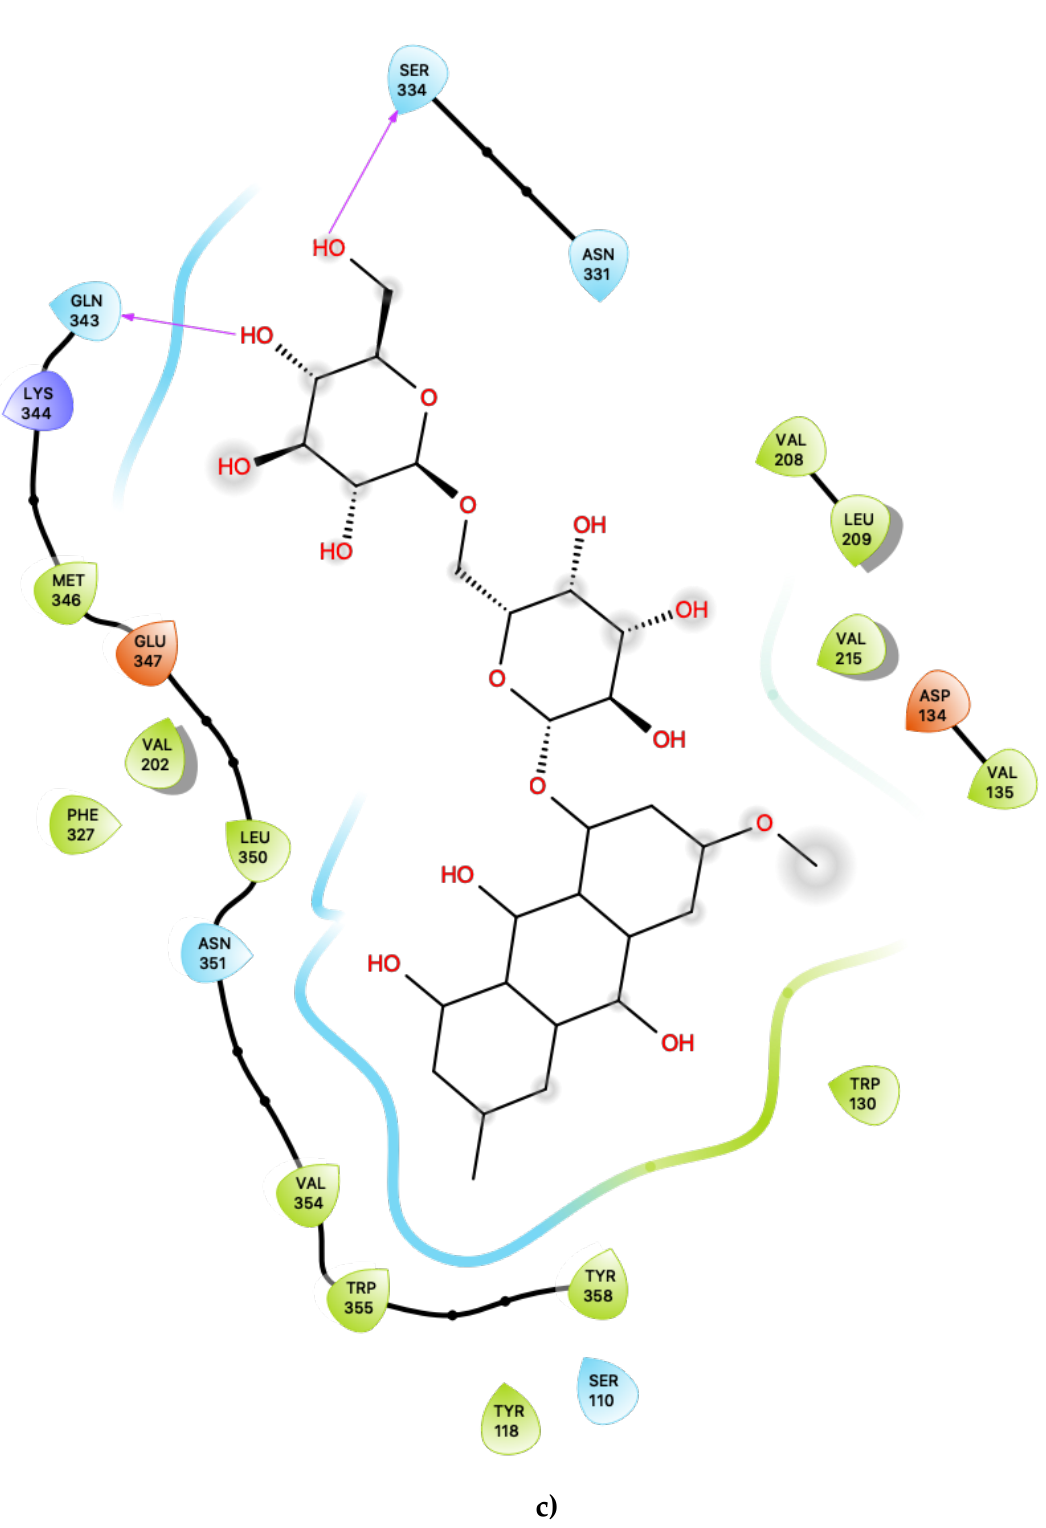
Figure 3. ( a ) Ligand-protein interaction of c06-S2, ( b ) c29-S2 and ( c ) c47-S2. Arrows indicate hydrogen bonds. Grey halos indicate solvent-exposed atoms.